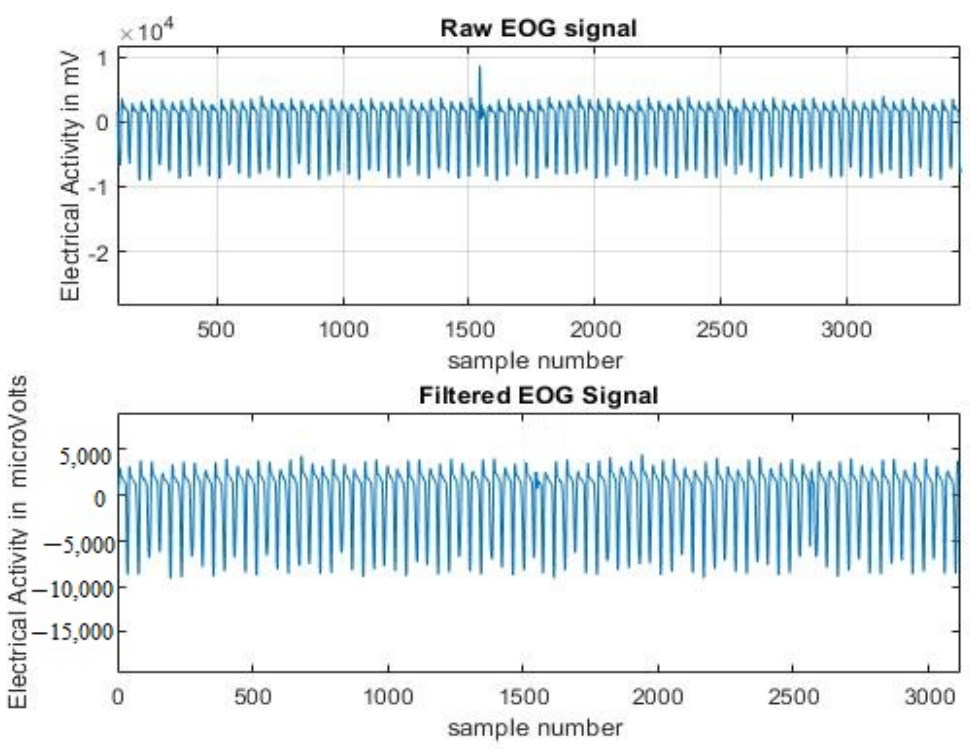
Figure 5. Raw and filtered EOG Figure 5 . Raw and filtered EOG signal.